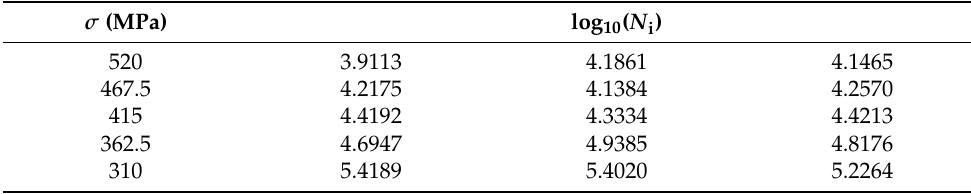
Table 2. Simulated samples generated from the known P-S-N equations.